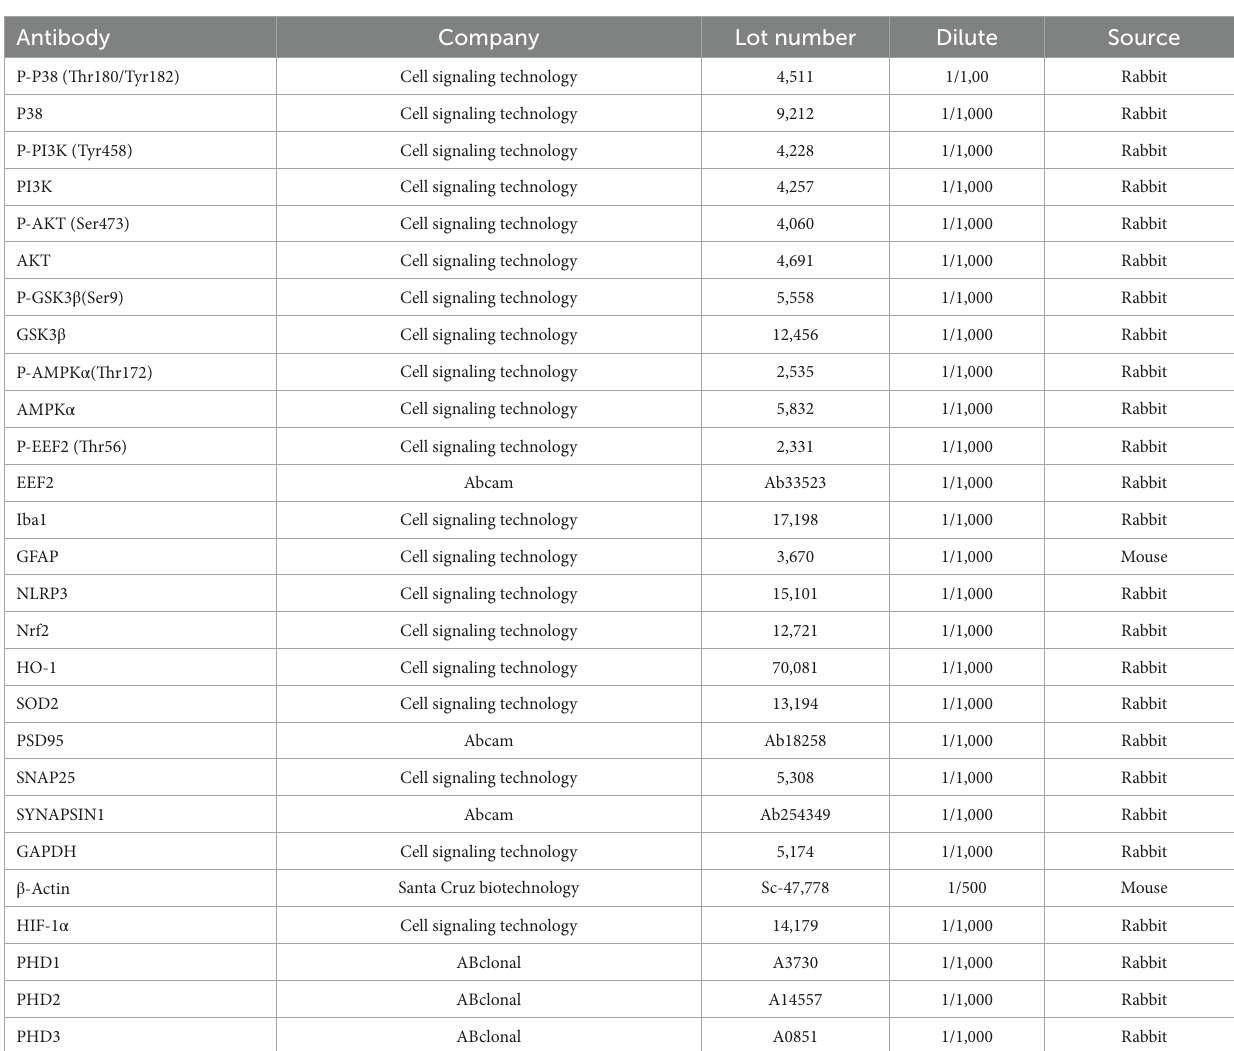
TABLE 1 List of antibodies.